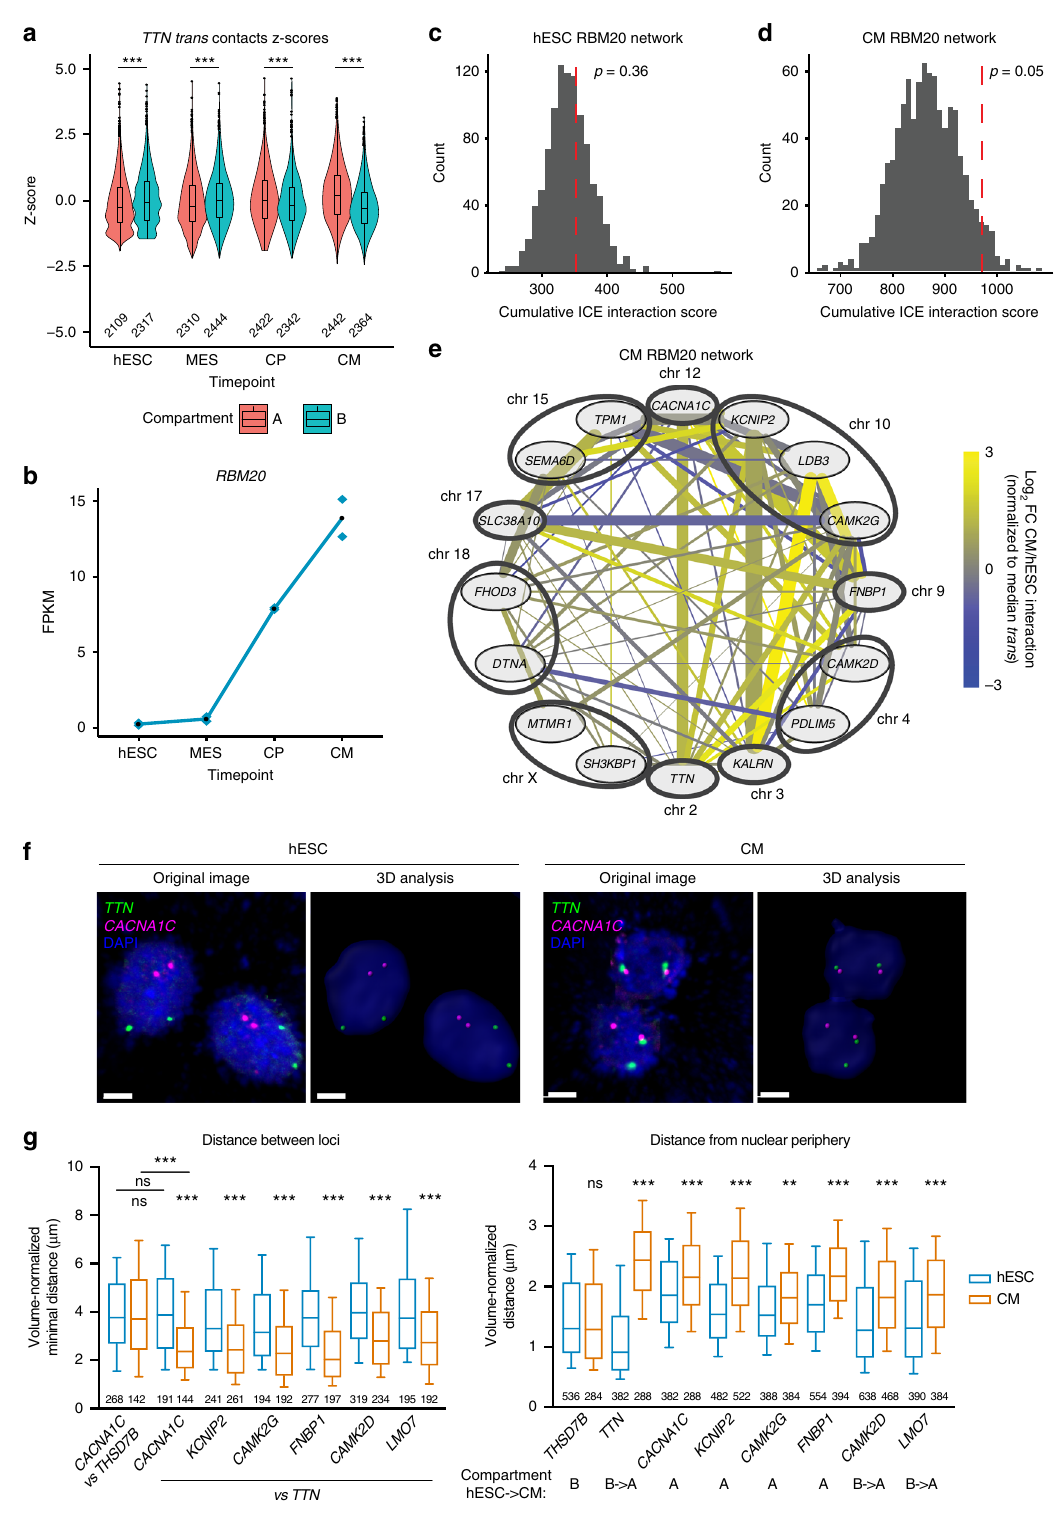
loci moves signi fi cantly closer to the TTN locus when hESCs differentiate into CMs (Fig. 6f, g and Supplementary Fig. 9a). Accordingly, these loci were found in proximity to TTN in 33 – 58% of all CM (compared with 8 – 24% in hESCs; Supple- mentary Fig. 9a). On the contrary, differentiation does not affect the distance between CACNA1C and THSD7B , a negative control region on the same chromosome as TTN but located in